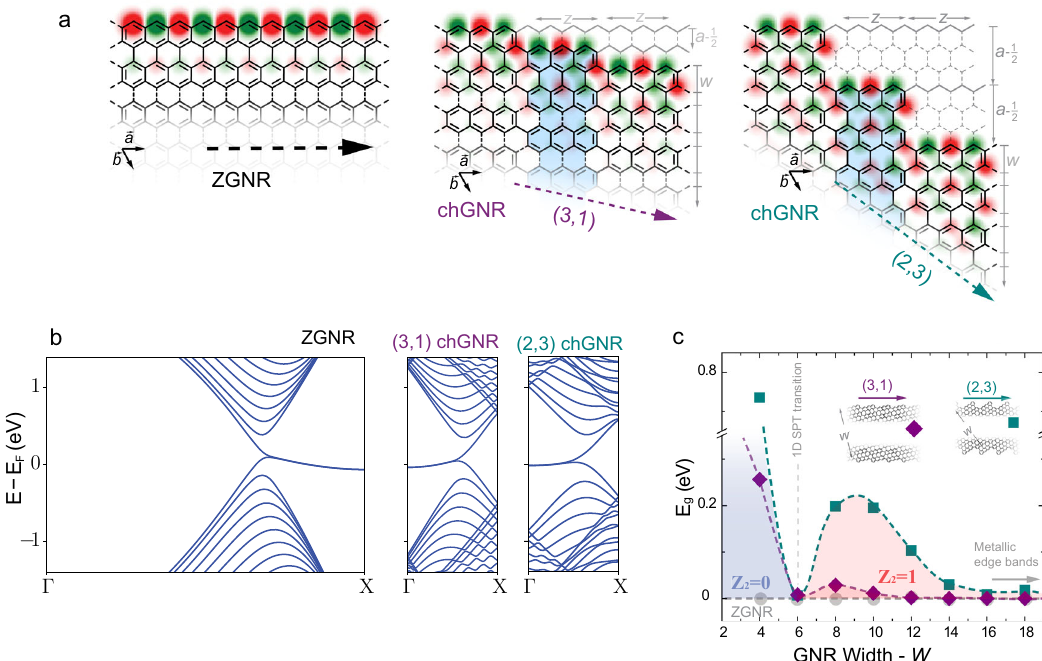
Fig. 1 Edge states in zigzag and chiral GNRs. a Edge structure of wide zigzag GNRs, and chiral GNRs with chiral vectors (3,1) and (2,3). Superimposed, tight-binding (TB) wavefunction amplitude of their zero-energy modes. The blue-shaded area indicates the rectangular graphene building block used for constructing a family of chiral GNRs, with edge structure alternating z zigzag and a -1/2 armchair segments. For the both chiral ribbons z = 3, while a = 1 and 2, respectively (details in the text and in Supplementary Note 1). b Band structure of 40-carbon wide ZGNR, and (3,1) and (2,3) chiral GNRs from TB simulations. The slight dispersion of the fl at bands is due to the inclusion of second-nearest neighbour interactions in our model (Supplementary Note 2). c Bandgap values of (3,1) and (2,3) chiral GNRs (purple diamond and blue squared symbols), as a function of the width (grey circles indicate the zero gap of ZGNRs). The value of the computed topological invariant Z 2 is indicated. A topological transition occurs for ribbons at the width w =